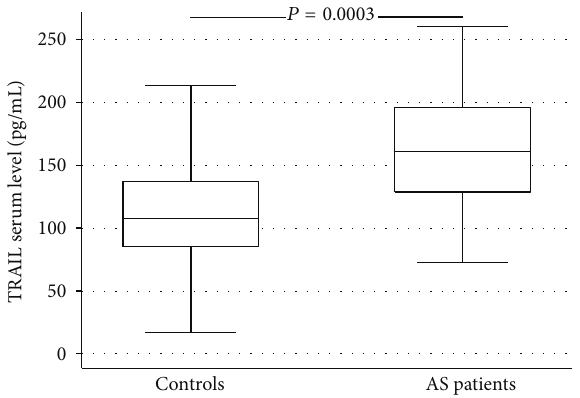
Figure 1: Box plot showing differences between AS patients and healthy controls matched by age, sex, and traditional CV risk factors in TRAIL serum concentration.